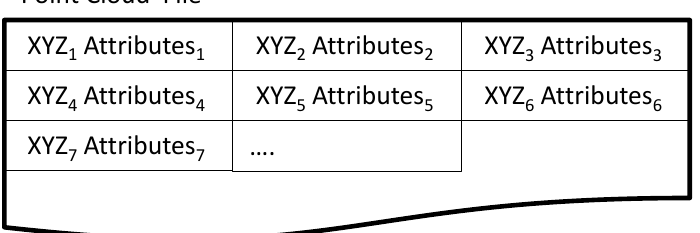
Figure 3. Simple point-attribute-relation storing coordinates and attributes in sequence. Point Cloud